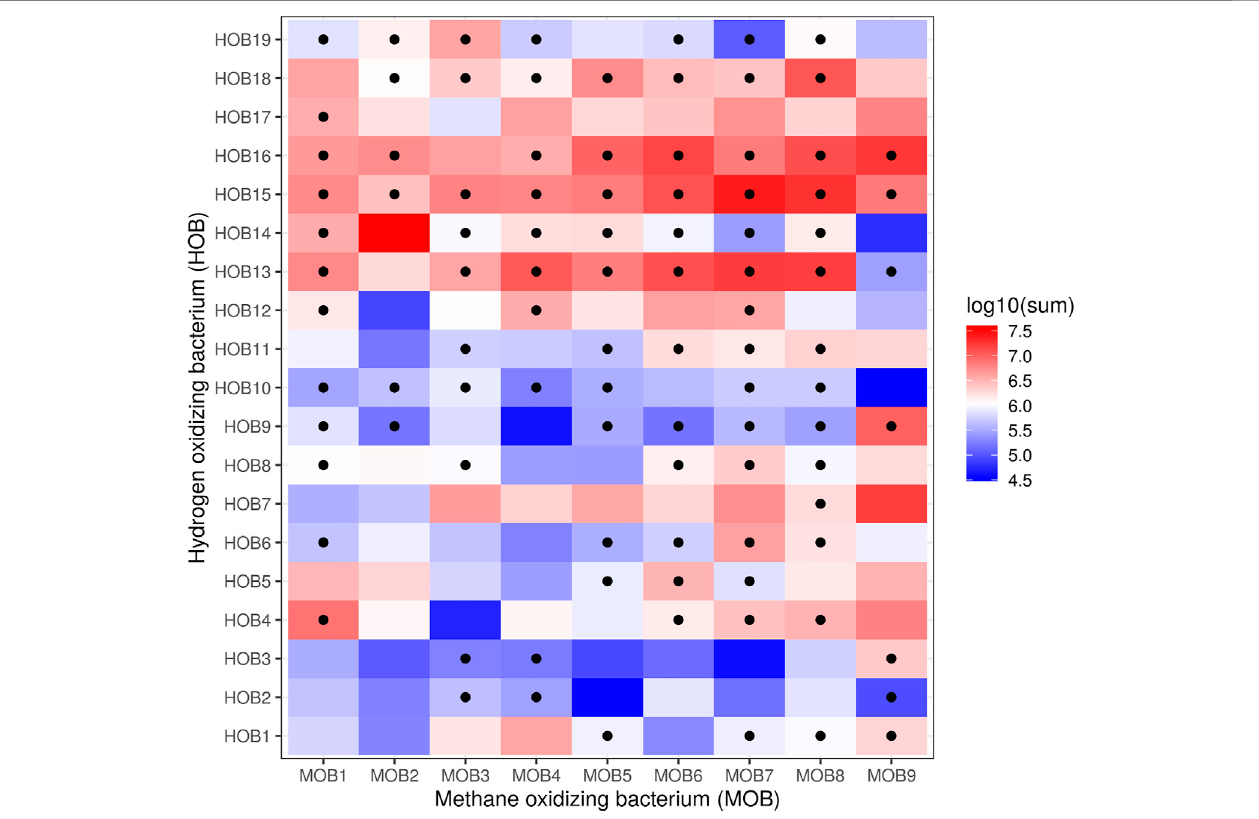
FIGURE 3 | Heatmap of log 10 CFU/mL plate counts of combinations of autotrophic hydrogen oxidizers (counted on DSMZ medium 81) and methanotrophs (counted on NMS), after a 10 4 dilution in PBS. Dots show combinations with a ratio of HOB/MOB between 0.5 and 2. The combinations of MOB with CNEC and XAUT were not evaluated through selective plate